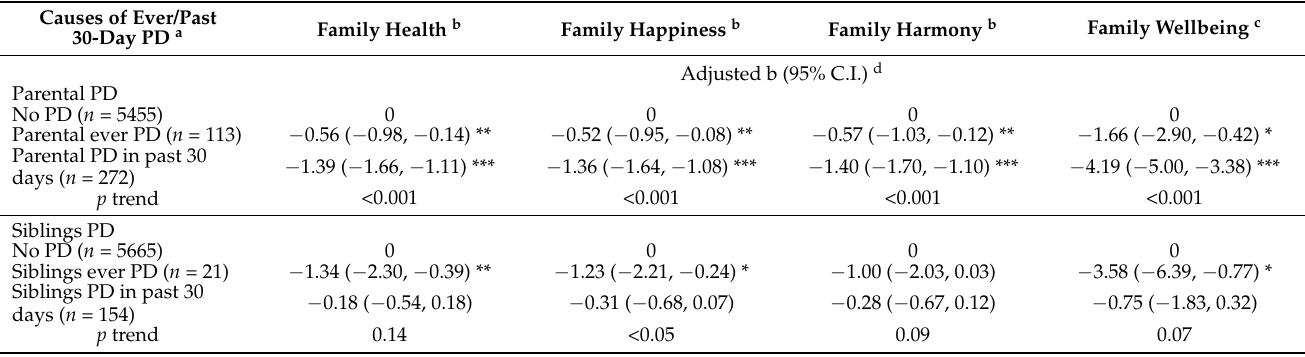
Table 4. Associations of ever and past 30-day family-caused passive drinking with family health, happiness, harmony, and wellbeing of 5840